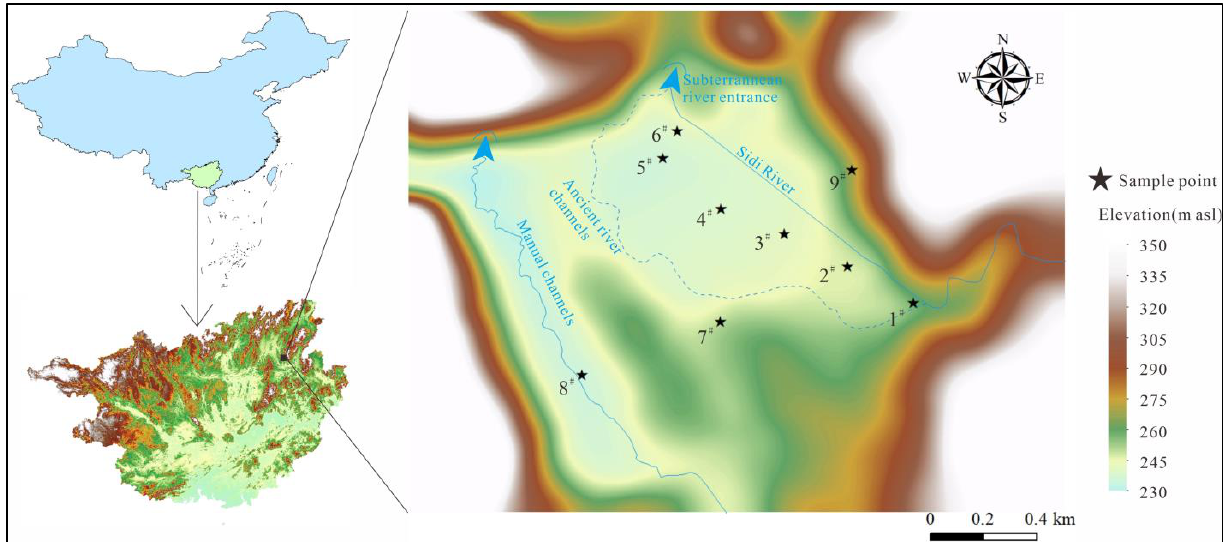
Figure 1. Study area and sediment sampling